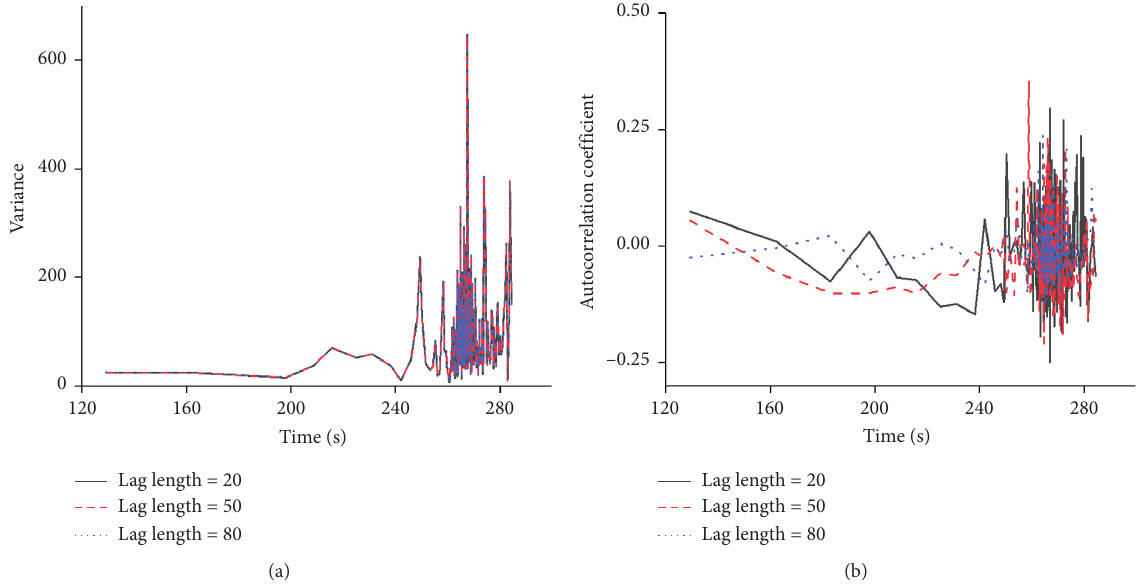
Figure 8: Variance and autocorrelation coefficient curves of AE counts with different lag step lengths under the same window length: (a) variance; (b) autocorrelation coefficient.